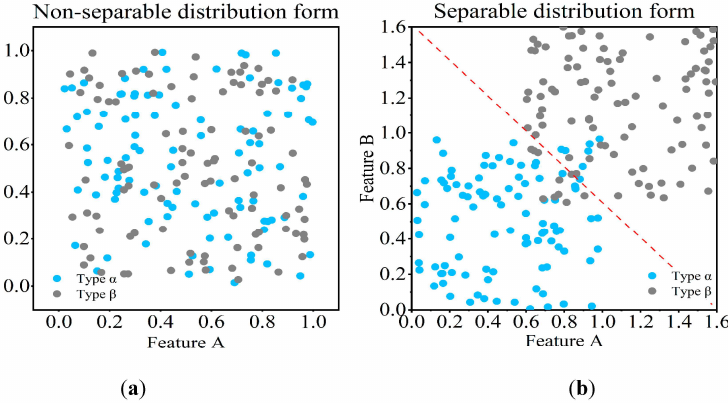
Figure 1. An illustrative example of non-separable distribution and separable distribution. ( a ) Non-separable distribution form; ( b ) Separable distribution form.